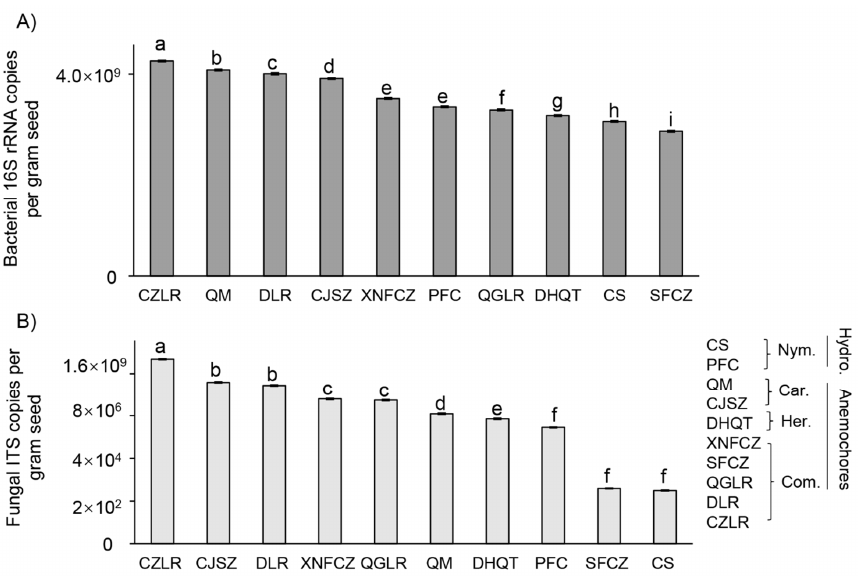
Figure 1. Seed microbial gene copy numbers determined by qPCR. Values are given by primers targeting ( A ) bacterial 16S rRNA and ( B ) the fungal ITS region in the seeds of two hydrochoric herbs (CS, Euryale ferox ; PFC, Nuphar pumila ) and eight anemochores including two herb species (QM, Dianthus superbus ; CJSZ, Dianthus repens ), three vine species (DHQT, Illigera grandiflora ; XNFCZ, Combretum griffithii ; SFCZ, Combretum wallichii ), and three tree species (QGLR, Terminalia myriocarpa ; DLR, Terminalia franchetii ; CZLR, Terminalia franchetii ). Lowercase letters above the bars indicate significant differences ( p < 0.05, ANOVA, Tukey HSD) of gene copies and the y -axis represents the unit on a log 10 scale. The abbreviations behind the bracket indicate plant family name (Car, Caryophyllaceae; Com, Combretaceae; Her, Hernandiaceae; Nym, Nymphaeaceae) and their assigned dispersal mode (hydrochores/anemochores). Detailed seed host plant pictures are presented in Figure